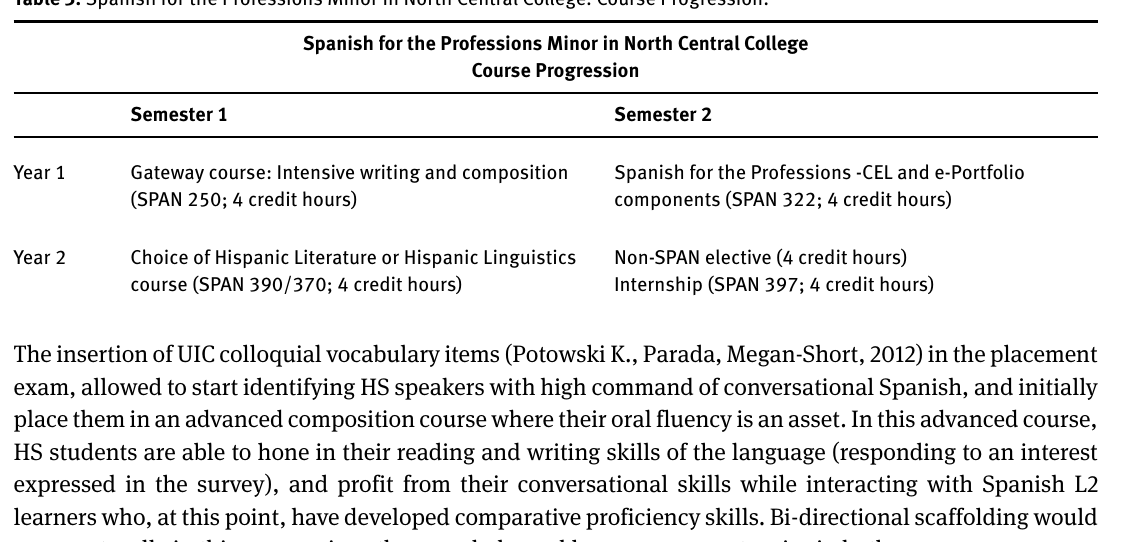
Table 3: Spanish for the Professions Minor in North Central College. Course